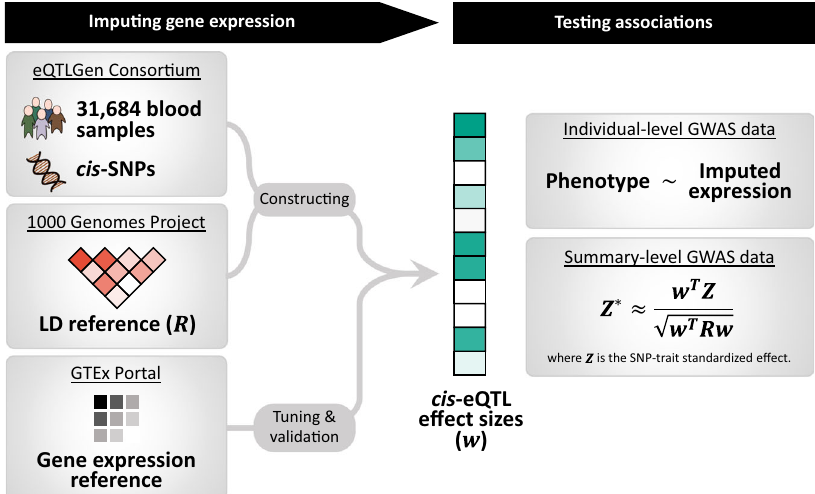
Fig. 1 | SUMMIT work fl ow. SUMMIT consists of three main steps: (1) building prediction models to impute gene expression levels; (2) testing associations between the predicted gene expression levels and the trait of interest; and (3) aggregating results from all fi tted prediction